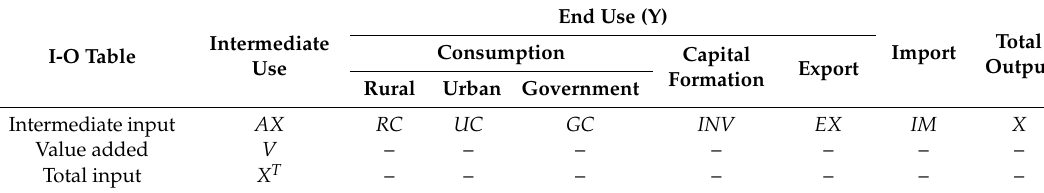
Table 3. A simplified competitive Input–Output